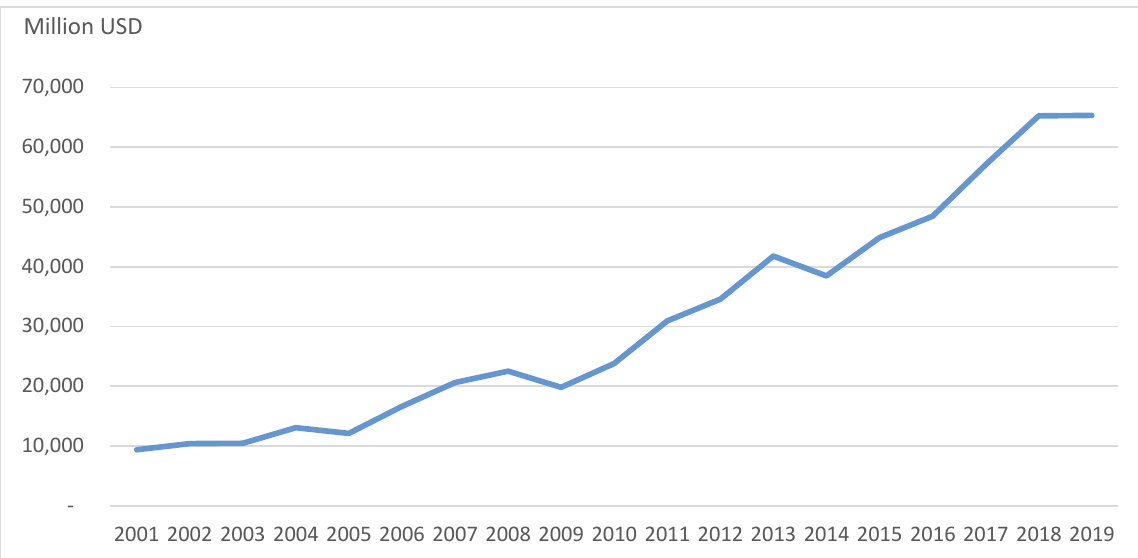
Fig. 2. The Tourism Revenue of Thailand